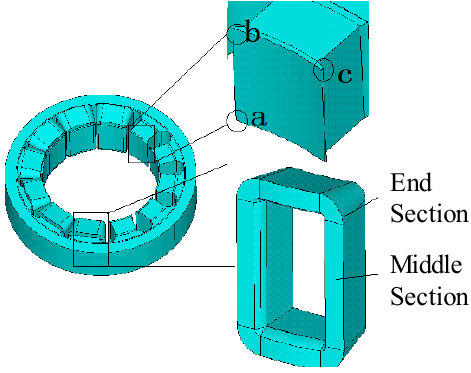
Figure 11. Schematic diagram of the stator components.